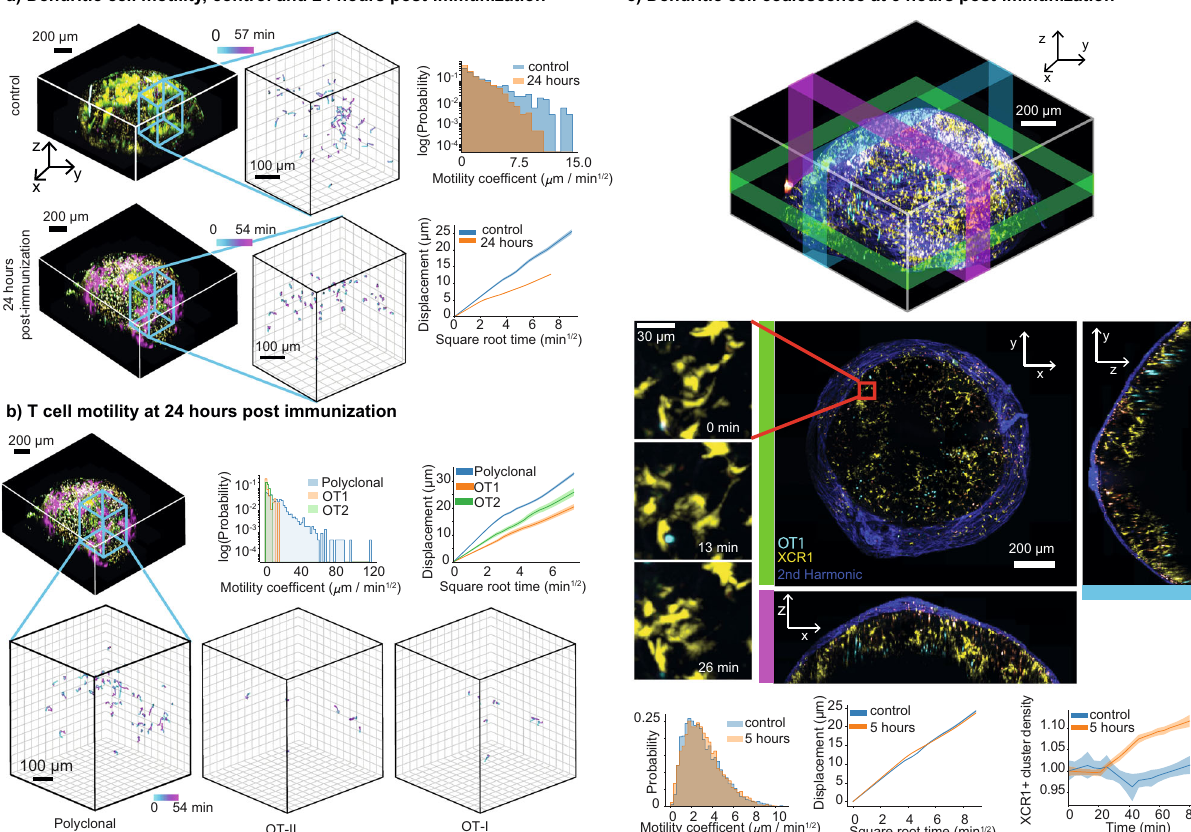
Fig. 3 Immune response under physiological conditions. a Distinct changes in global behavior of antigen-presenting cells as measured by XCR1 + dendritic cell motility 24 h after immunization show the cell behavioral correlates of developing immune responses. (Left) Tracks of motility in control and 24 h post immunization, (right top) log histograms of motility coef fi cients, and (right bottom) displacement vs square root of time show that dendritic cells switch from faster random walk behavior in the control (i.e., straight line in bottom right plot) to slower, con fi ned motility 24 h post immunization. b T cell motility at 24 h post immunization. (Top middle) log histograms of OT1, OT2, polyclonal T cells. (Top right) Displacement vs square root of time plots. (Bottom) tracks of T cell motility. c Dendritic cell clustering can be visualized and quanti fi ed on the whole lymph node level. (Top) 3D view with colored bars marking areas shown in 2D projections below. XY, YZ, XZ projections with zoomed-in area show an example of dendritic cell cluster forming over 26 min. (Bottom) Histograms of dendritic cell motility at 5 h post infection vs control, mean displacement vs square root of time, mean normalized density over time in 5 h post infection vs control dataset show that formation of dendritic cell clusters can be detected on the timescale of 1 h, but without any detectable change in dendritic cell motility. Error bars on all plots show 95% con fi dence